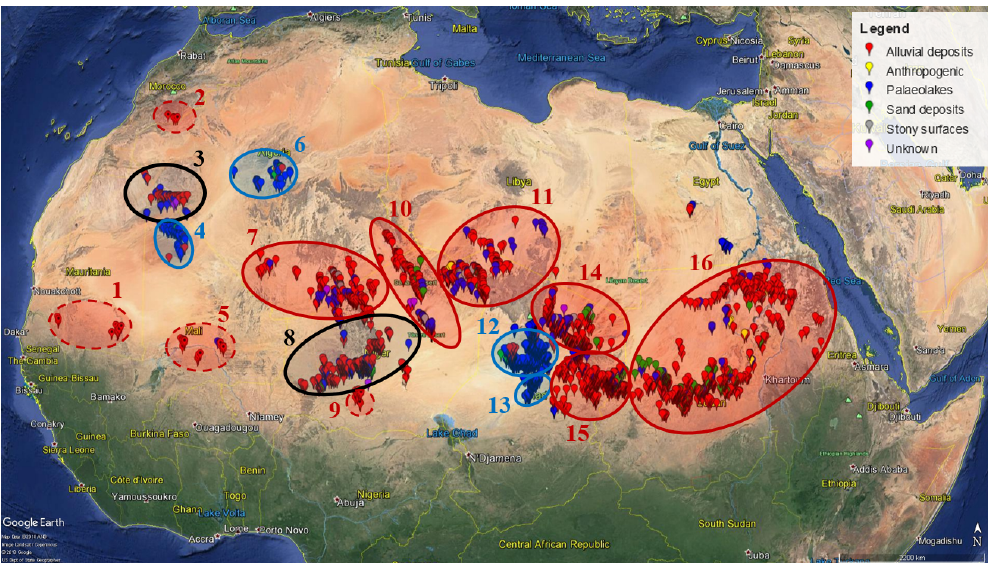
Figure 3. Geomorphology of the northern African mineral dust sources of the 2015–2017 boreal winter dust seasons. Coloured pins represent individual dust point sources of the 20 largest dust storms of the 2015–2017 winter dust seasons, with the colour signifying the geomorphic category of the dust point source. The major dust source regions are outlined, with red regions containing predominantly alluvial deposit dust sources, blue regions containing predominantly palaeolake dust sources, and black regions containing a mixture of alluvial deposit and palaeolake dust sources. The regions with dashed outlines were regions that emitted dust during the dust seasons, but did not emit during the 20 largest dust storms of the 2015–2017 winter dust seasons. Source areas are numbered as follows: 1 – Mauritania, 2 – Draa